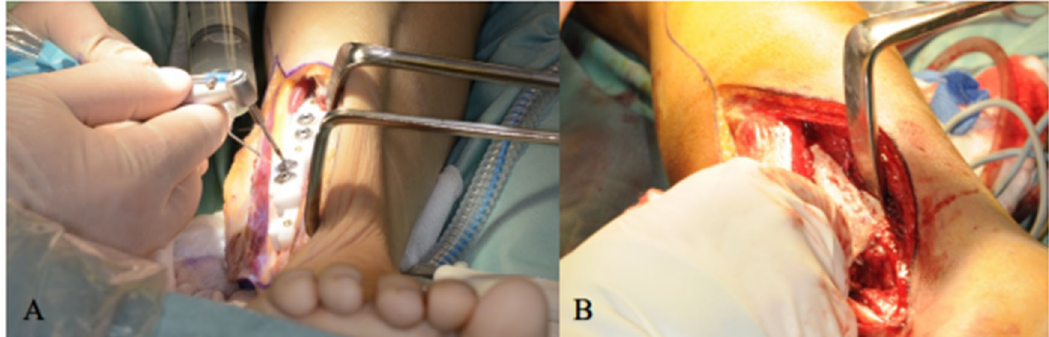
implants are placed in the planned location. ( B ) Split-thickness skin graft placed over the lateral aspect of the fibula containing the